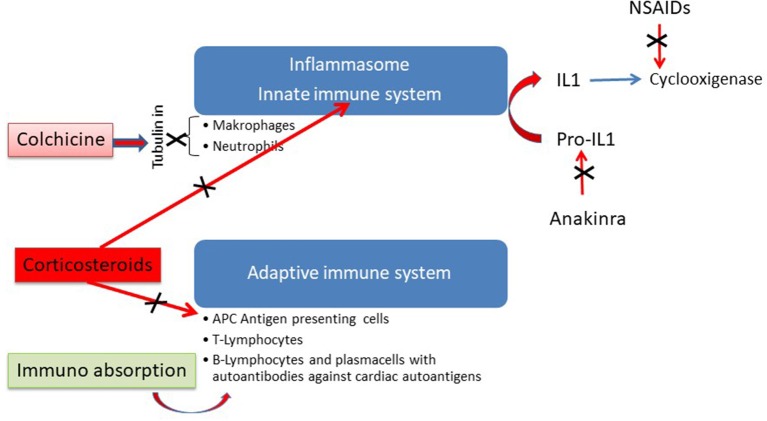
Antininflammatory action of different modes of therapy in perimyocarditis [modified from Maisch (69) with permission from Springer-Nature].